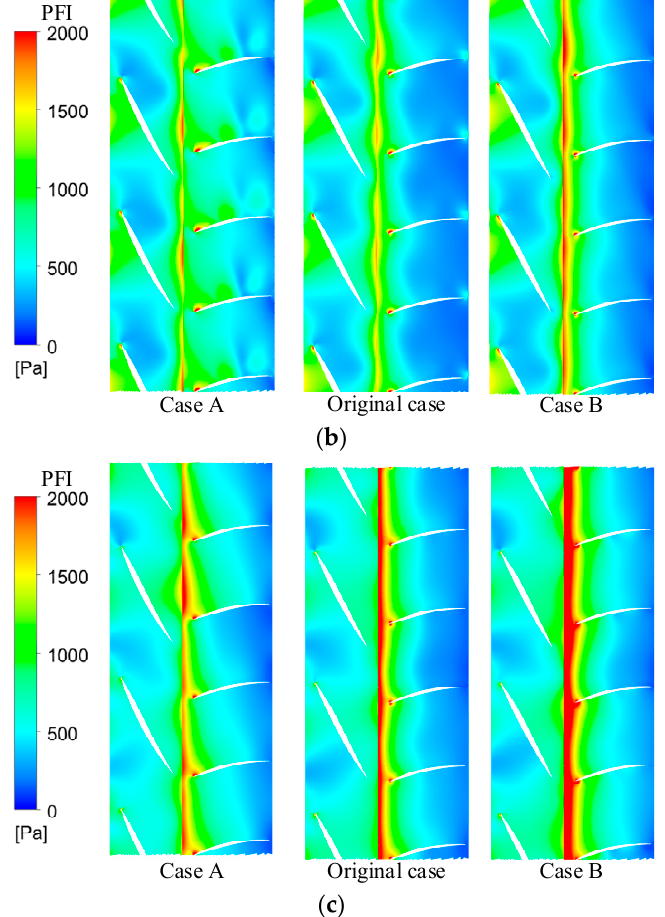
Figure 11. The distribution of PFI in the passage of impeller and guide vanes under ( a ) 0.7 Q des , ( b ) 1.0 Q des and ( c ) 1.15 Q des . (Span = 0.5).